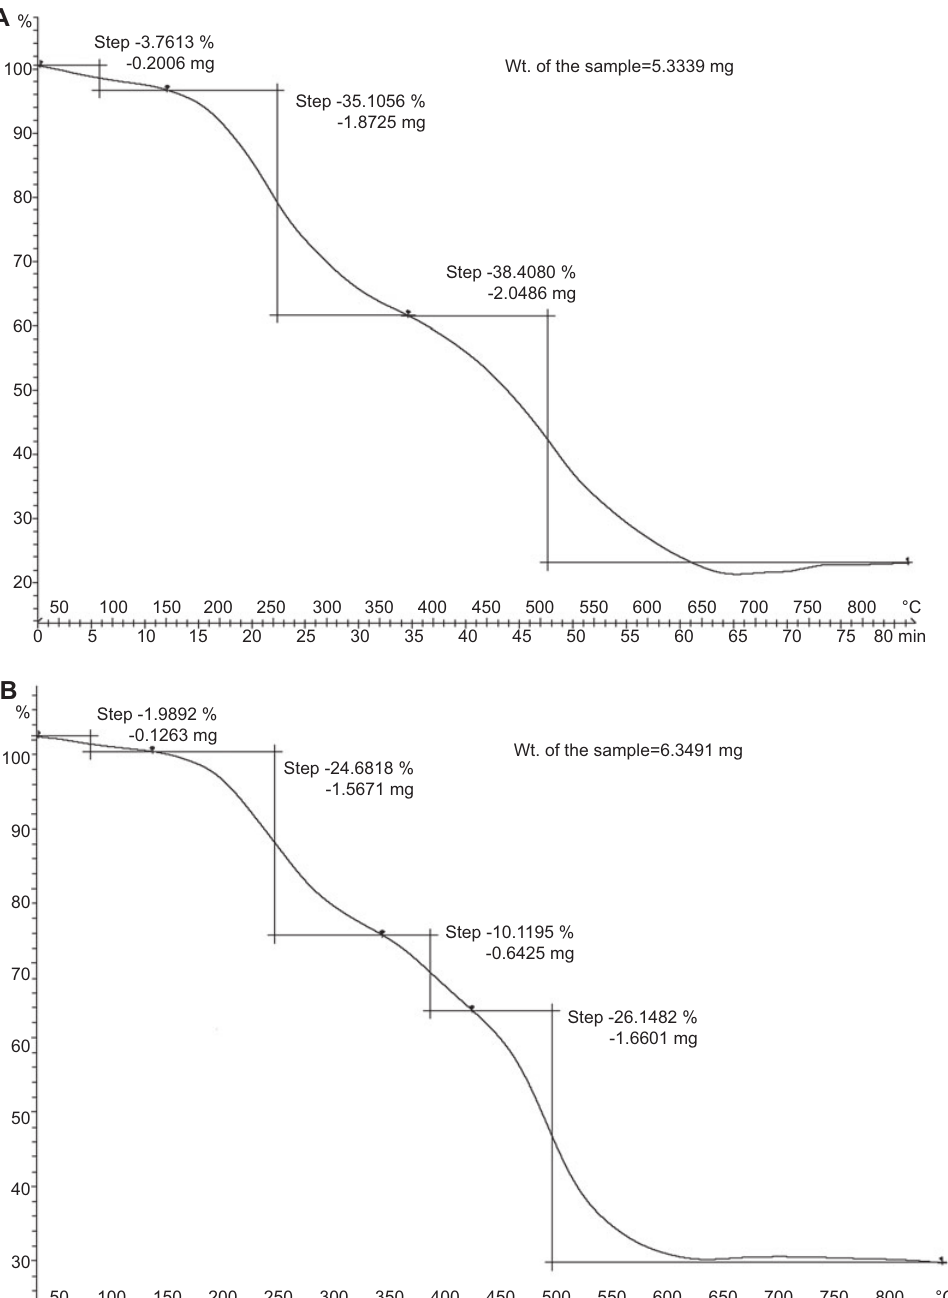
Figure 2 TG curve (weight % vs. temperature ° C) of: (A) (3) and (B) (4) .